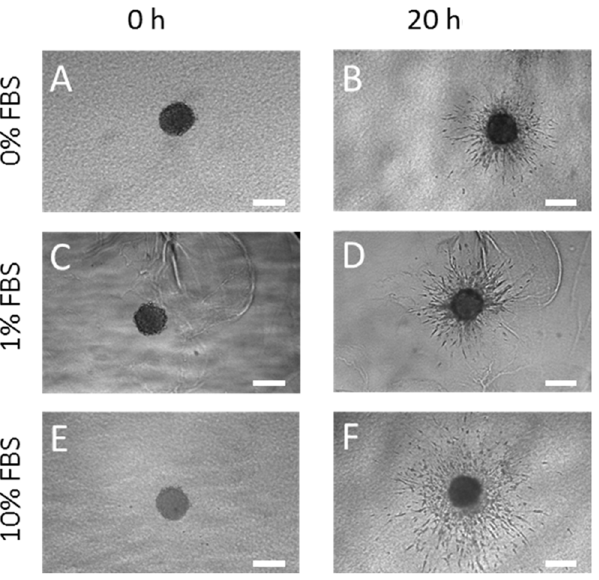
Fig 8. FBS influence on U-87-MG spheroid invasion. U87-MG spheroids were embedded in collagen hydrogel in a six well plate and growth media supplemented with 0%FBS (A and B), 1% FBS (C and D) and 10% FBS (E and F), was applied over them. Photos were taken at embedding time (0 hours) and after 20 hours. Scale bar is 200 μ